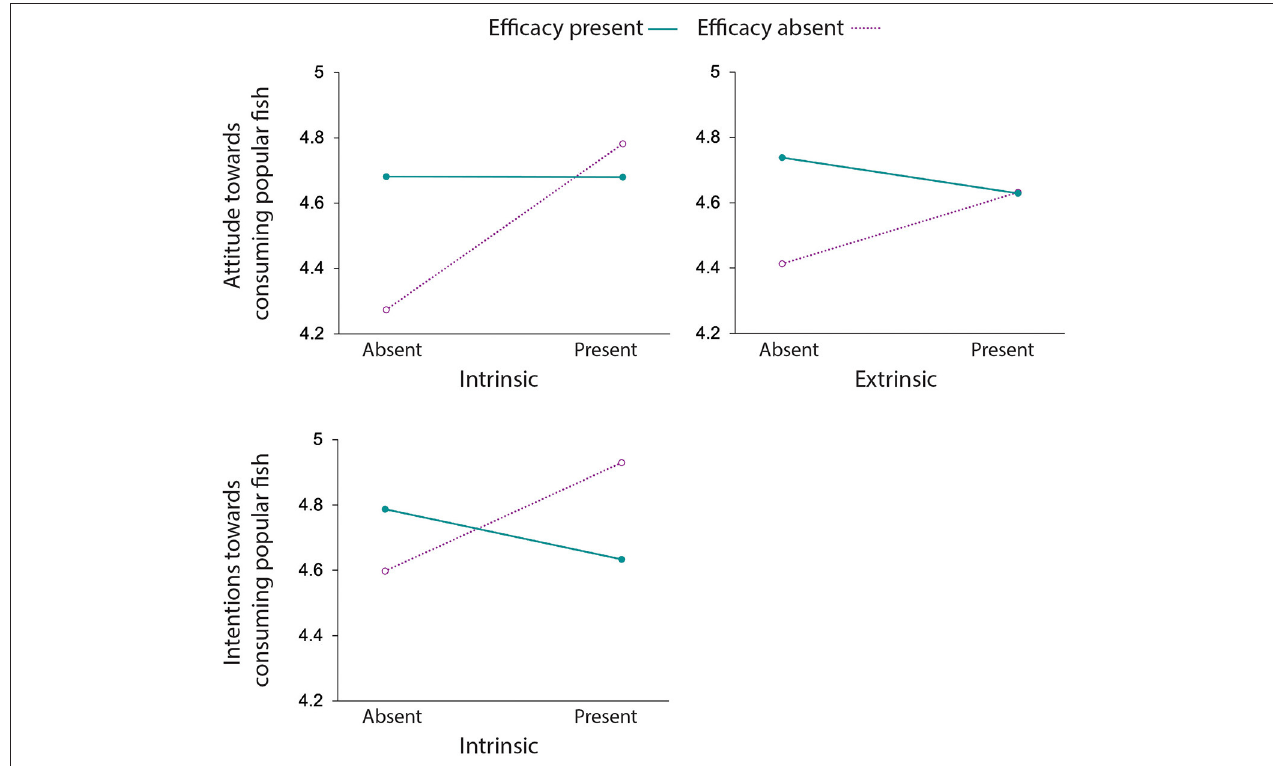
FIGURE 4 | Interactions between intrinsic and extrinsic risk messages and efficacy message on attitudes and intentions toward popular fish consumption.